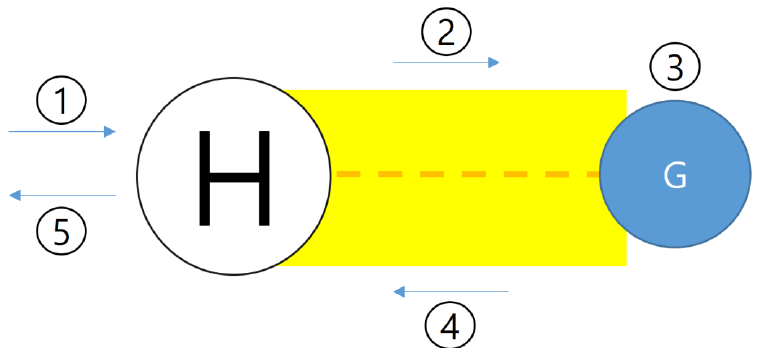
Figure 23. Operation process on a vertiport. ① is arrival, ② is taxing to gate, ③ is gate, ④ is taxing to vertiport, ⑤ is departure.